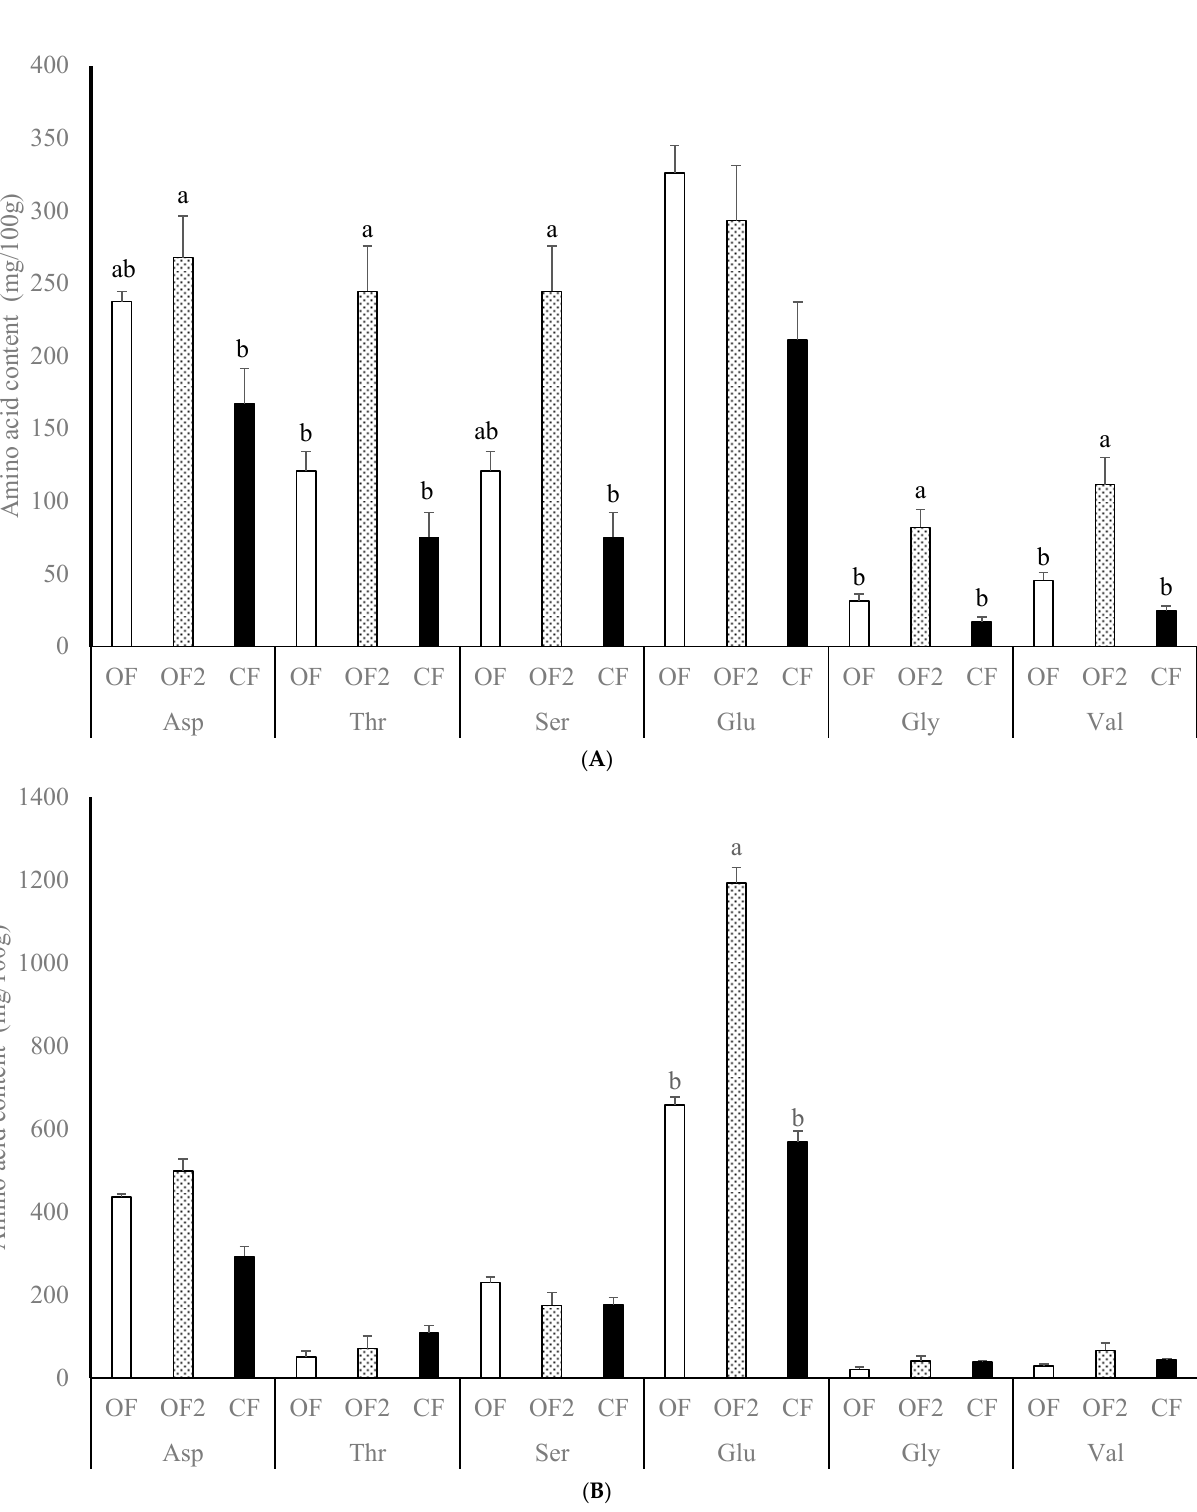
Figure 3. The effect of different fertilizers on the amino acid content of bok choy leaves. ( A ): Summer, ( B ): Autumn. Error bars on vertical columns indicate standard error ( n = 3). Identical letters between bars indicate no significant difference ( p < 0.05) among treatments according to Tukey’s multiple range test. OF (organic fertilizer): corn steep liquor (CSL) applied as organic fertilizer at the same amount of total nitrogen as that in the half unit of Otsuka A formula; OF2: CSL applied at twice the amount of total nitrogen in OF; CF (chemical fertilizer): half unit of Otsuka A formula.